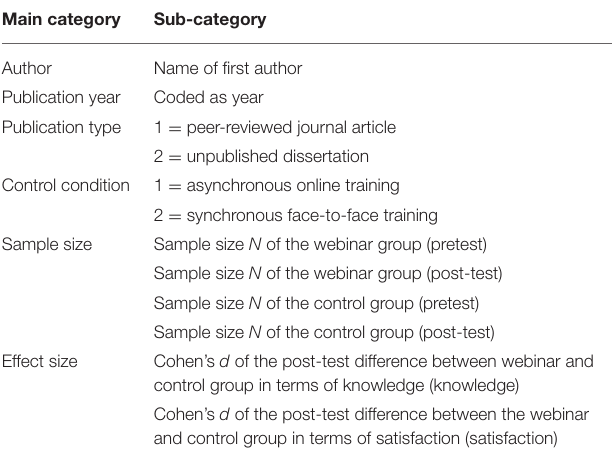
TABLE 2 | Coding scheme.